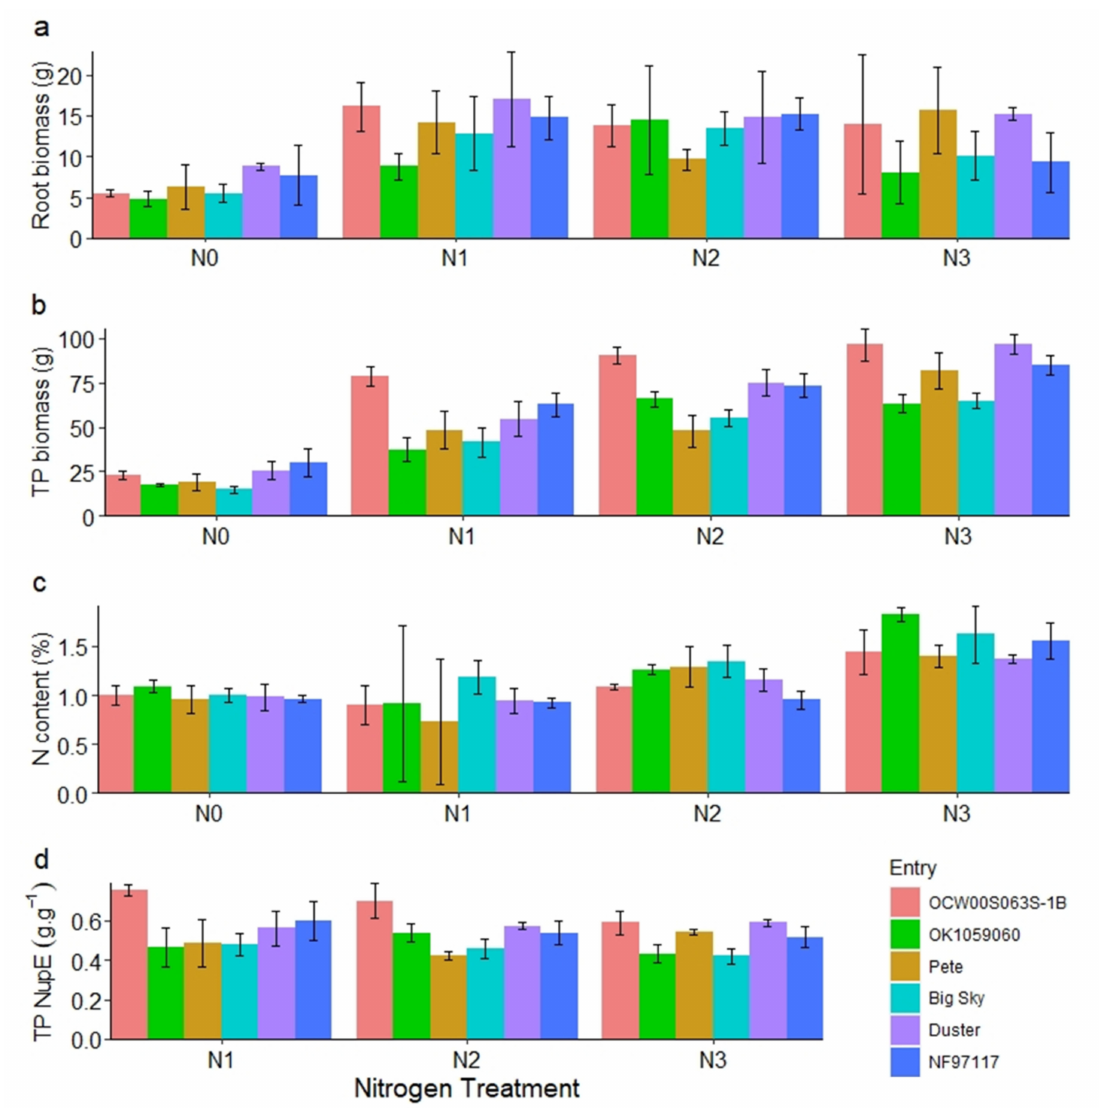
Figure 5. Root biomass ( a ), total plant biomass ( b ), N content ( c ), and total plant N uptake e ffi ciency ( d ) of the six wheat lines evaluated in hoop house under three di ff erent N rates. Among the six wheat lines evaluated in the hoop house, NUE showed a perfect positive relationship with shoot biomass—very high with NUpE, TP biomass, and TP NUpE and moderate with NUtE and root biomass at all N treatments (Table 3). A poor positive correlation was observed between NUtE and NUpE, which tended to decrease as more N was applied. As expected, shoot N content, which is a part of CP, showed a negative correlation with biomass, NUtE, NUpE, and NUE [24,32]. Furthermore, NUpE showed a positive correlation with